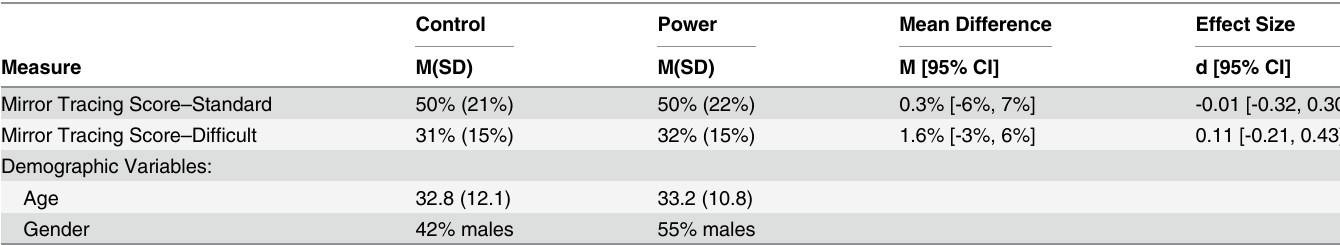
Table 4. Experiment 4: Summary of Group